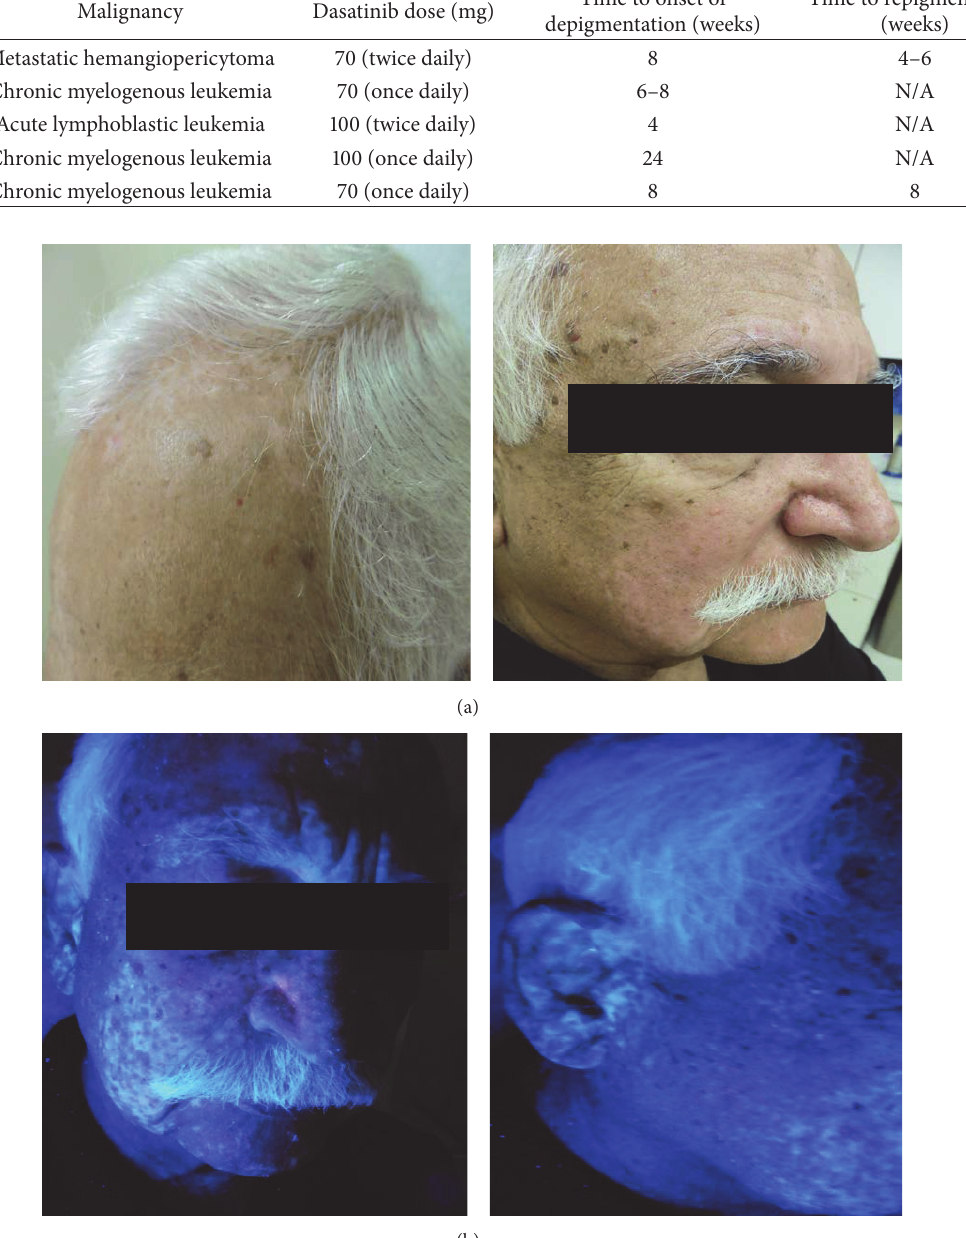
Figure 1: Hypopigmented and depigmented areas on the (a) face, scalp, and (b) ears, highlighted on Wood’s lamp